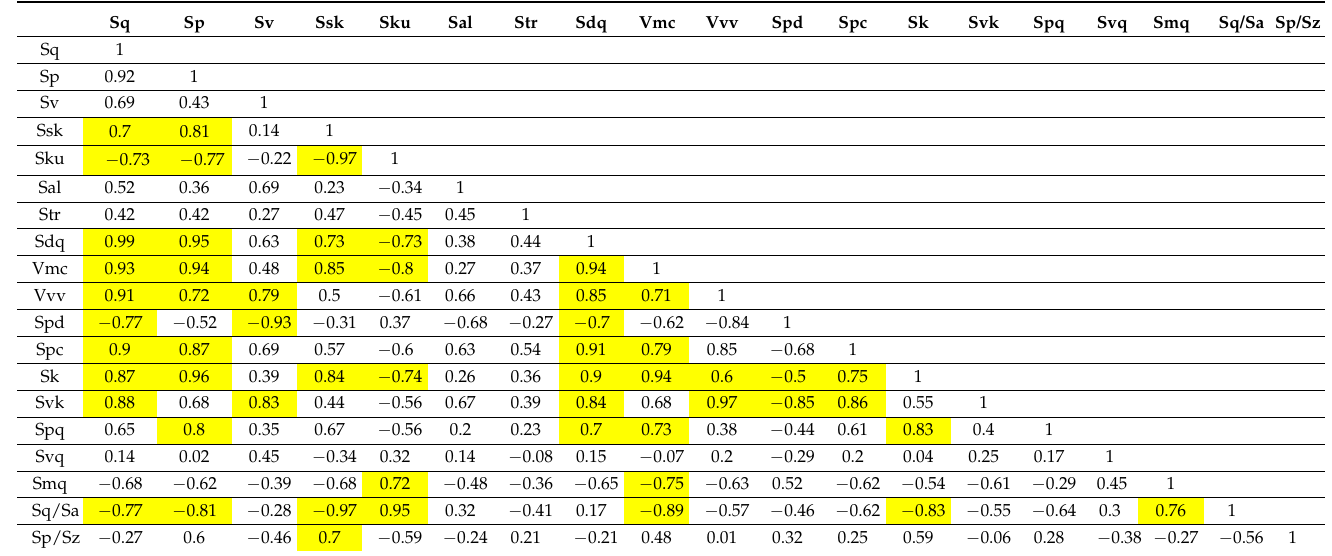
Table 1. Coefficients of linear correlation between the selected parameters of the plateau-honed cylinder surfaces, the strong correlations are marked by yellow